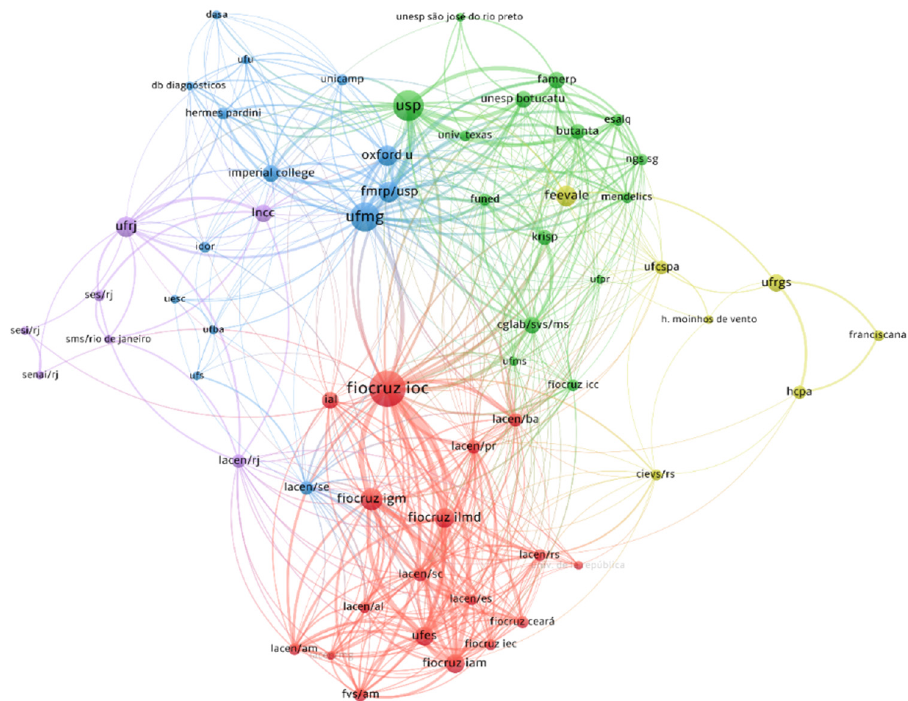
Figure 5. Organisation co-authorship map. Organisations with at least three articles in the systematic review were included ( n = 63 out of 229). Connectors indicate co-authorship. The number of included articles from each organisation weighted circle sizes. Five clusters were found, and are indicated by different colours. Metadata is available in Table S7.